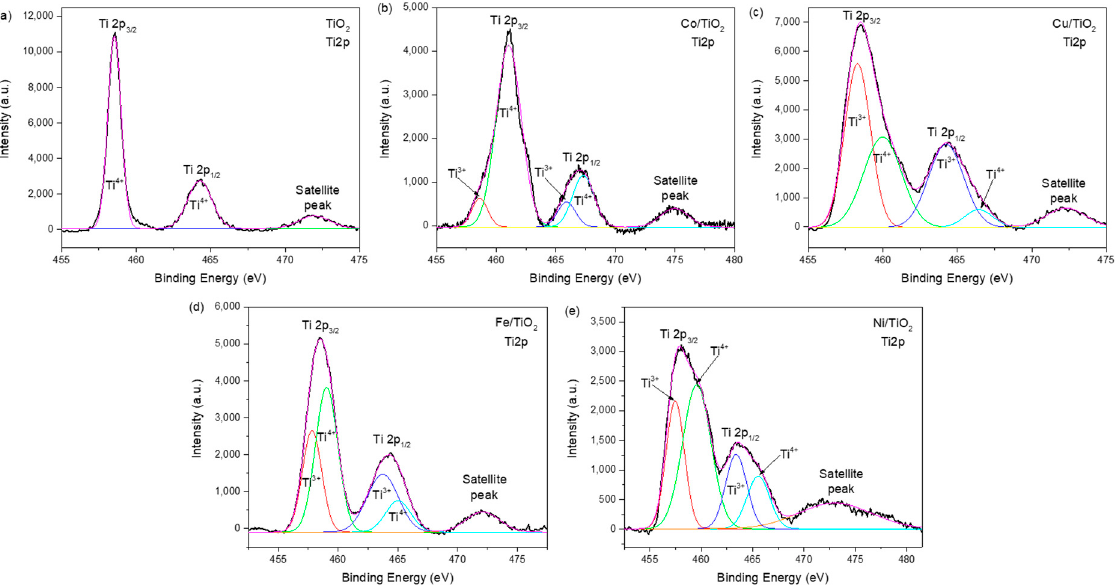
Figure 8. Ti2p XPS spectrum of: ( a ) TiO 2 , ( b ) Co/TiO 2 , ( c ) Cu/TiO 2 , ( d ) Fe/TiO 2 and ( e ) Ni/TiO 2 .